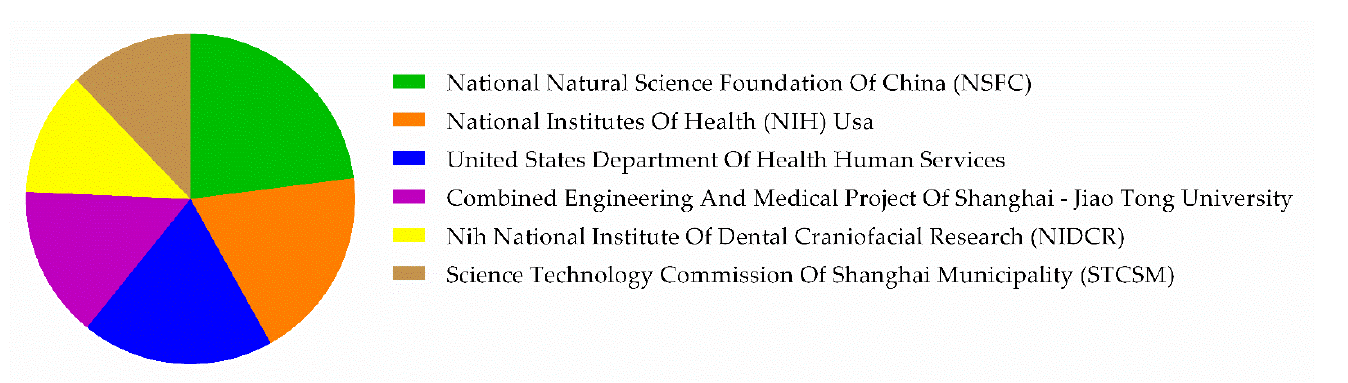
Figure 5. The USA, Italy, and Spain are the most productive Countries. The graphical representation shows the number of issues per Country for the 12 most productive Countries.